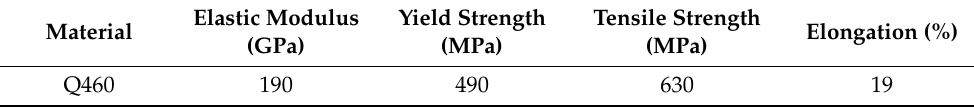
Table 2. Mechanical properties of Q460 low-carbon steel.